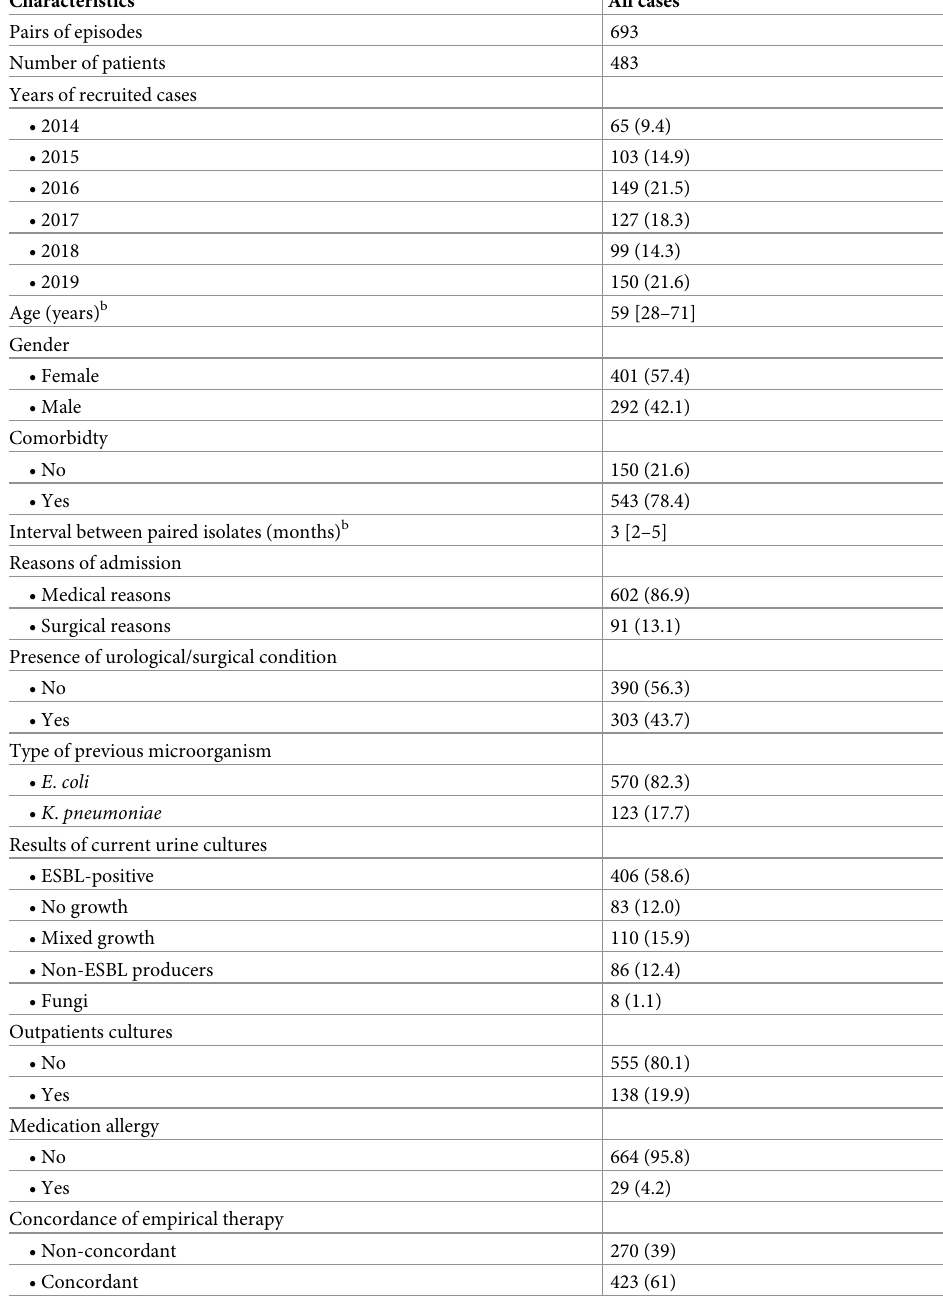
Table 1. Demographic and clinical